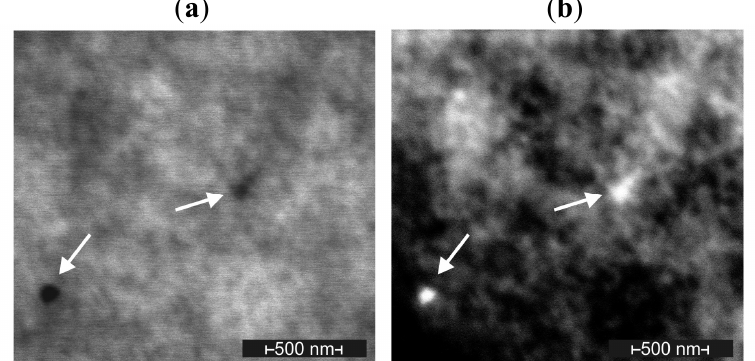
Figure 3. Micrographs showing AgNPs in a composite with 160 ppm AgNPs. Scanning transmission electron image using ( a ) the wet-STEM detector and ( b ) the gaseous secondary electron detector